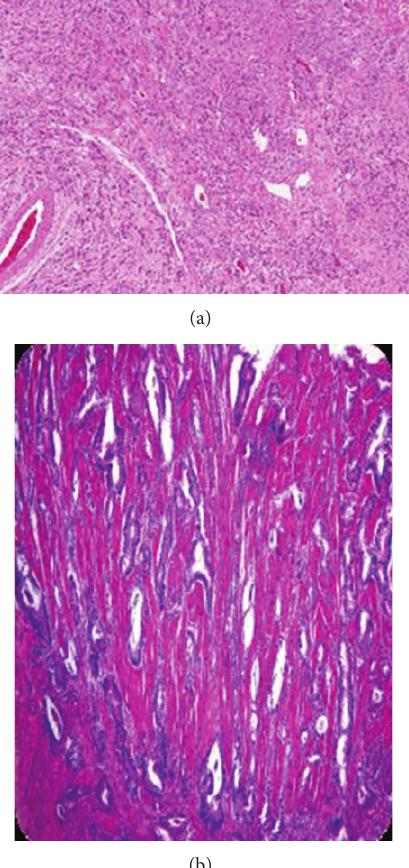
Figure 7: Histological finding was “poorly differentiated adenocar-